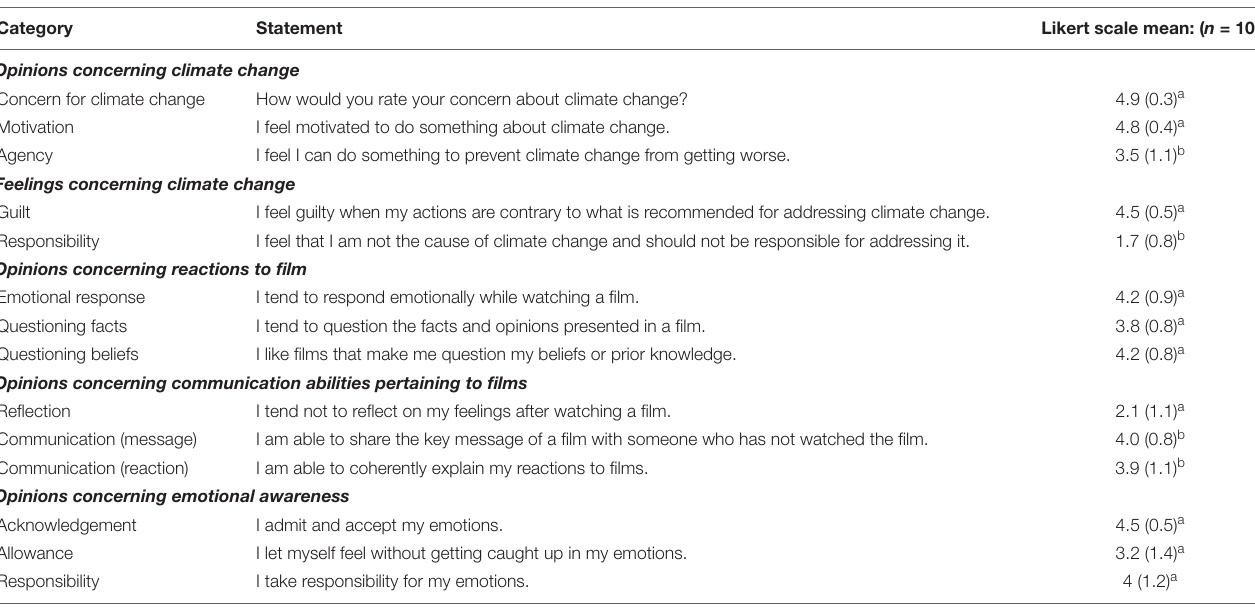
TABLE 3 | Likert scale results from the pre-term questionnaire grouped under five groups: opinions concerning climate change, feelings concerning climate change, opinions concerning reactions to film, opinions concerning communication abilities pertaining to films, and opinions on emotional